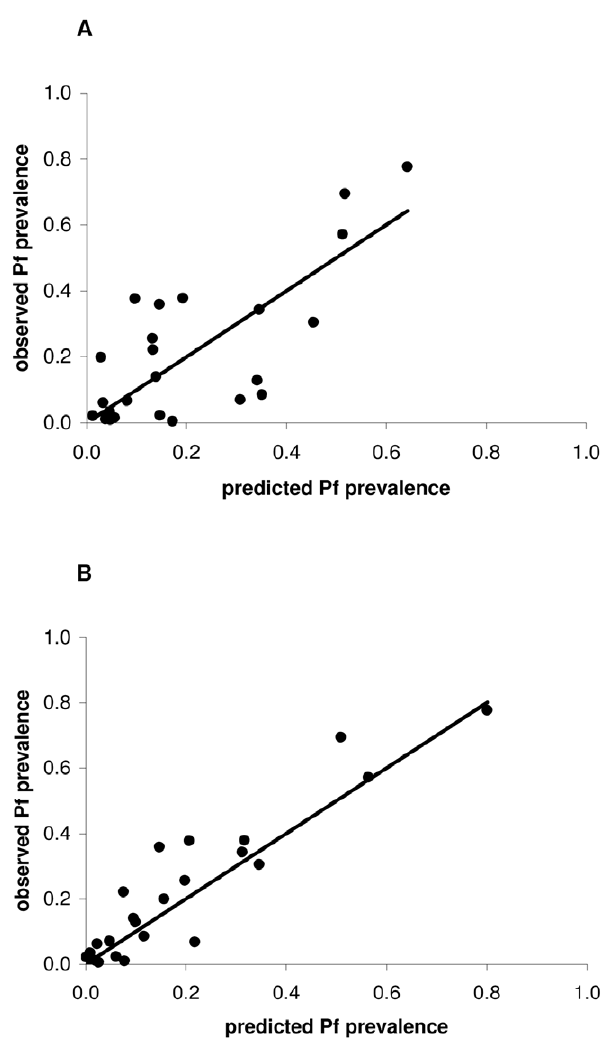
Figure 3. Regression model goodness-of-fit. Area of predicted malaria vector habitat improves the goodness-of-fit of models of malaria prevalence, assessed by regression of observed versus predicted malaria prevalence in children 2 to 9 years old. Assessments were performed for (A) an ordinary least squares regression model of P. falciparum prevalence as a function of altitude, and (B) a conditional autoregressive model of P. falciparum prevalence as a function of altitude and habitat. Data points represent 24 villages in north eastern Tanzania. The 1:1 line is shown for reference.